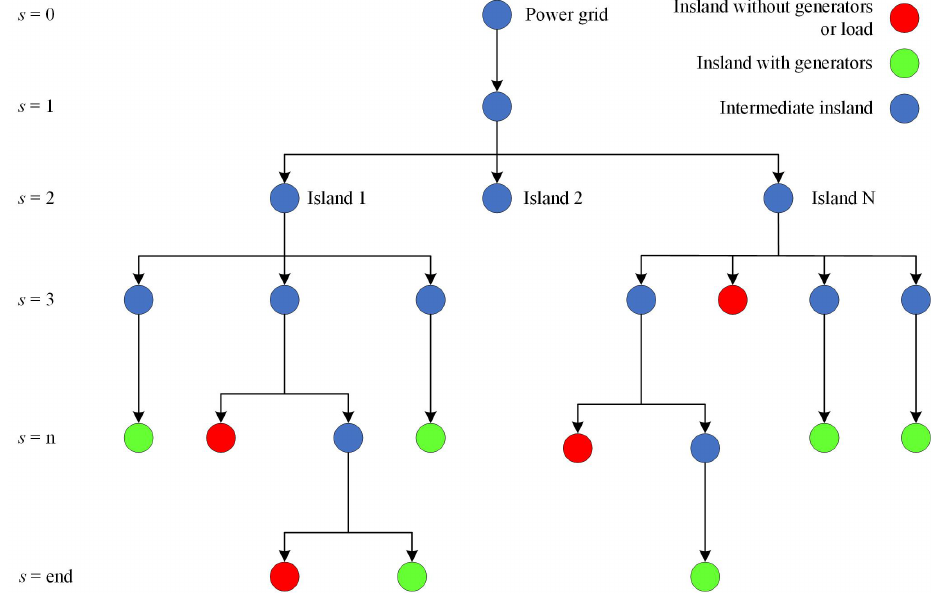
Figure 4. A tree structure of the cascading failure